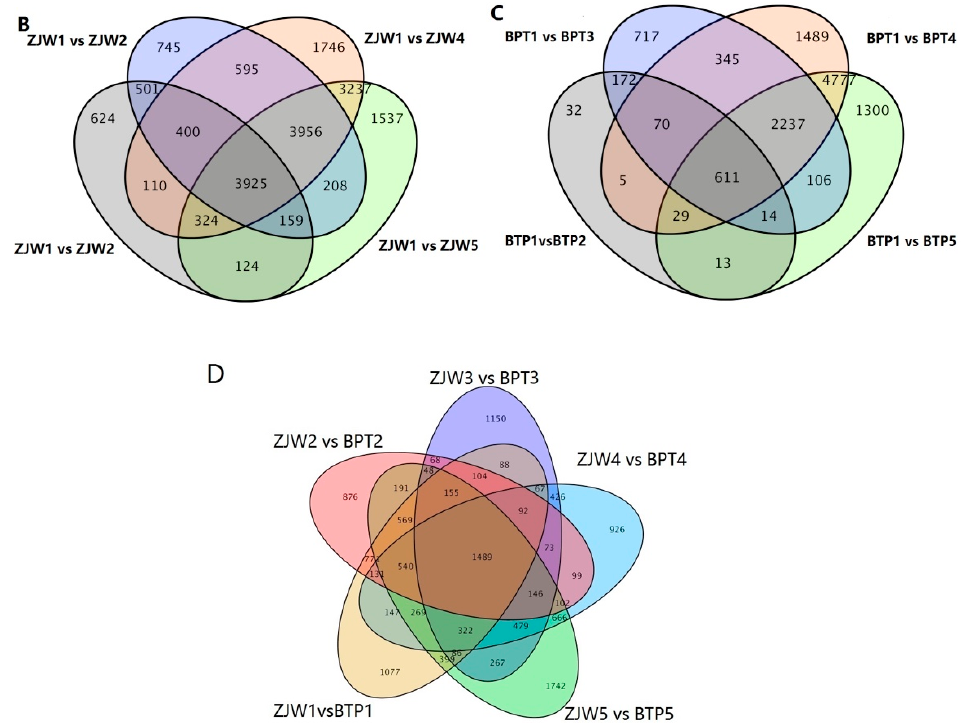
Figure 4. DEGs statistics and Venn diagrams between di ff erent cDNA libraries. ( A ) The number of DEGs between ZJW and BTP developmental stages. ( B ) Venn Diagram of DEGs between white flower tea development stages. ( C ) Venn Diagram of DEGs between pink flower tea development stages. ( D ) Venn diagram of DEGs between ZJW and BTP at the 5 developmental stages.